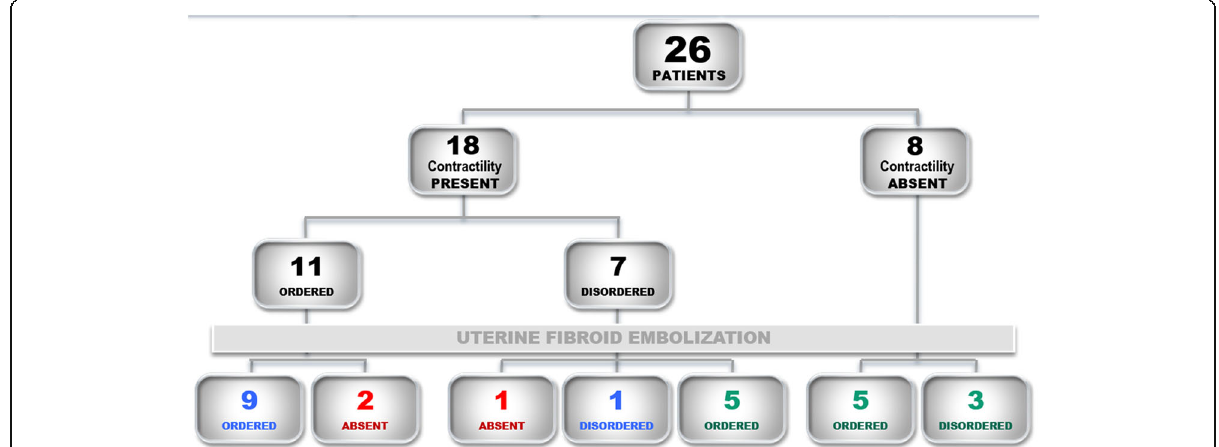
Fig. 1 Stratification of participants by uterine contractility before and after UFE. Blue, group A; green, group B; red, group